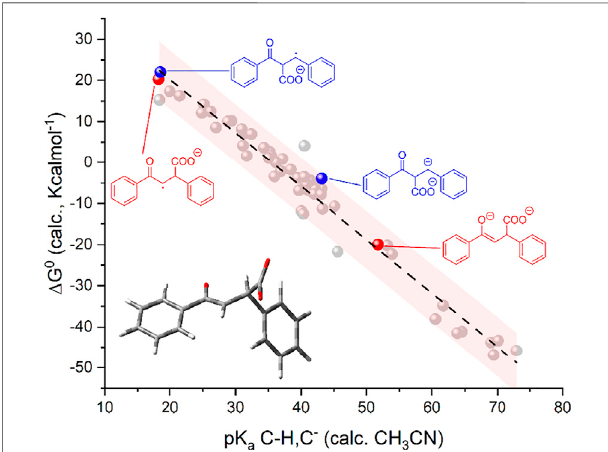
FIGURE 4 | Plot of calculated standard free energy of carboxylation ( Δ G 0 1 ) vs. calculated pK a of the CH/C − couples. Red dots indicate chalcone derivatives upon carboxylation in the β position; blue dots indicate chalcone derivatives upon carboxylation in the α position. The light gray dots indicatethe50organicmoleculesreportedin Chart1 andplottedin Figure1 . Inset: optimized geometry of the carboxylated product in β starting from C(DA)